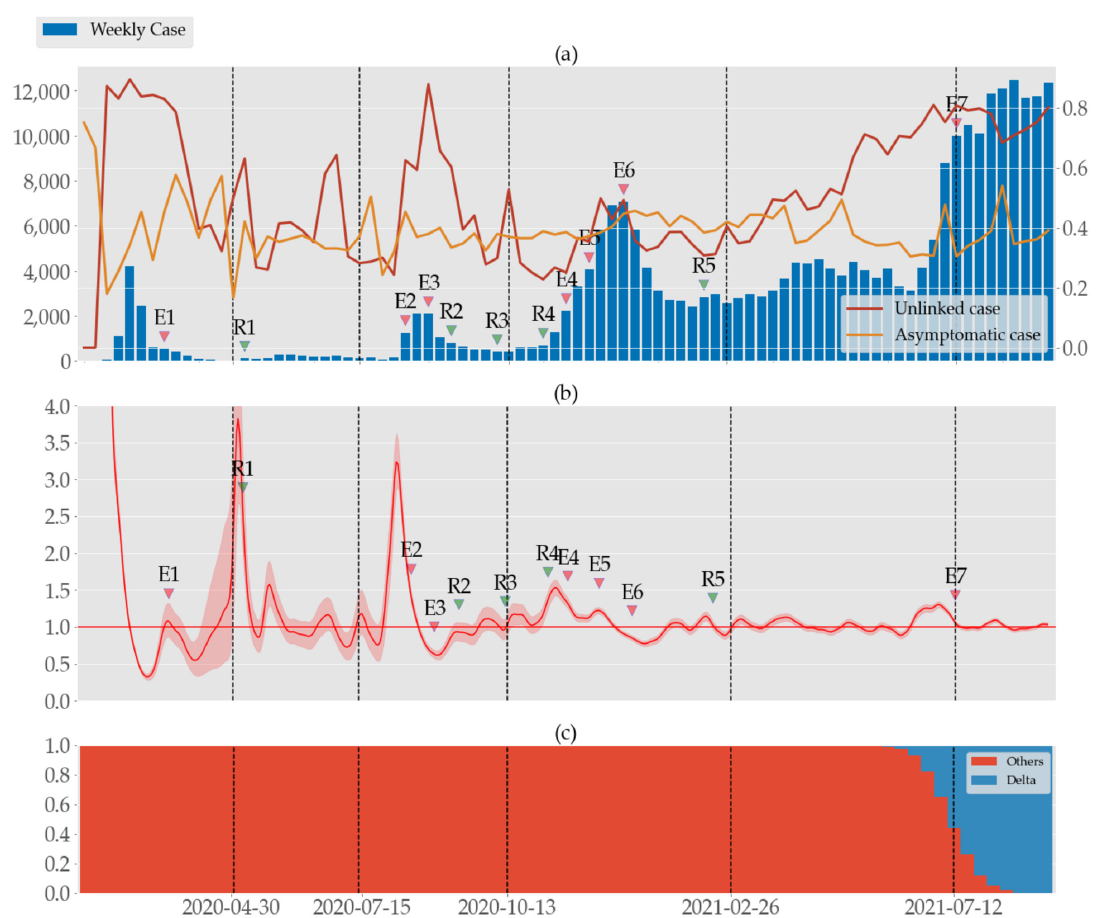
Figure 1. ( a ) Weekly number of local cases (blue bars) together with the proportions of unlinked cases (red) and asymptomatic cases (orange) in South Korea from 19 January 2020 to 16 September 2021, divided into six periods by vertical dashed lines. ( b ) Estimated daily effective reproduction number R t and its 95% confidence interval. The red horizontal line marks the critical threshold R t = 1. The red/green arrows mark the strengthening/relaxation of social distancing policies. See Table S1 for a detailed explanation of the policies. ( c ) Rates of the delta variant and the preceding ones such as alpha and beta